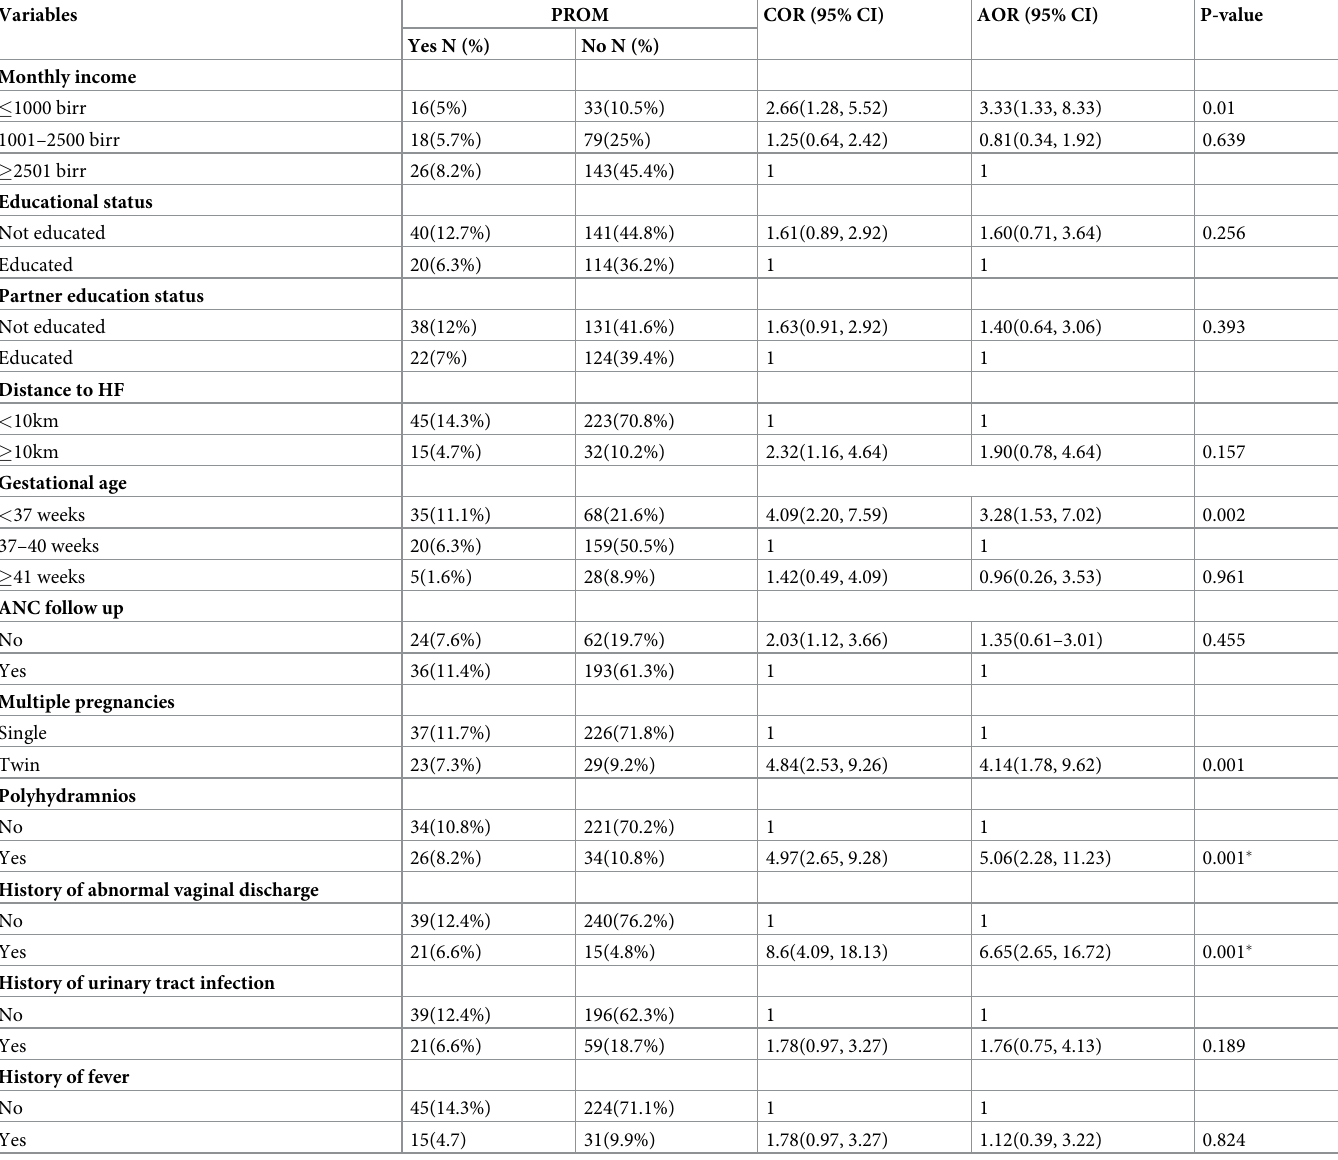
Table 4. Bi-variable and multivariable analysis of PROM and associated factors among pregnant women admitted to the maternity ward at Debre Markos Referral Hospital,